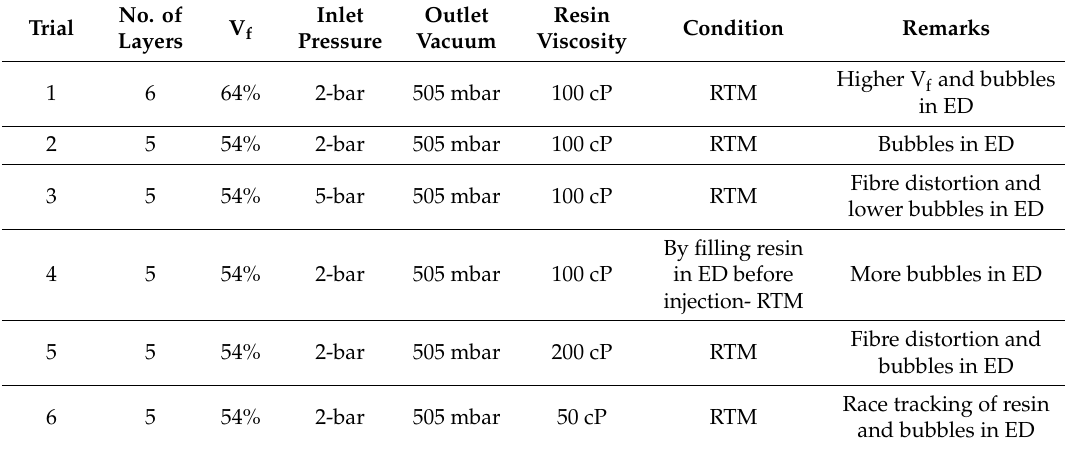
Table 3. Initial manufacturing trials with di ff erent injection parameters for ED integrated